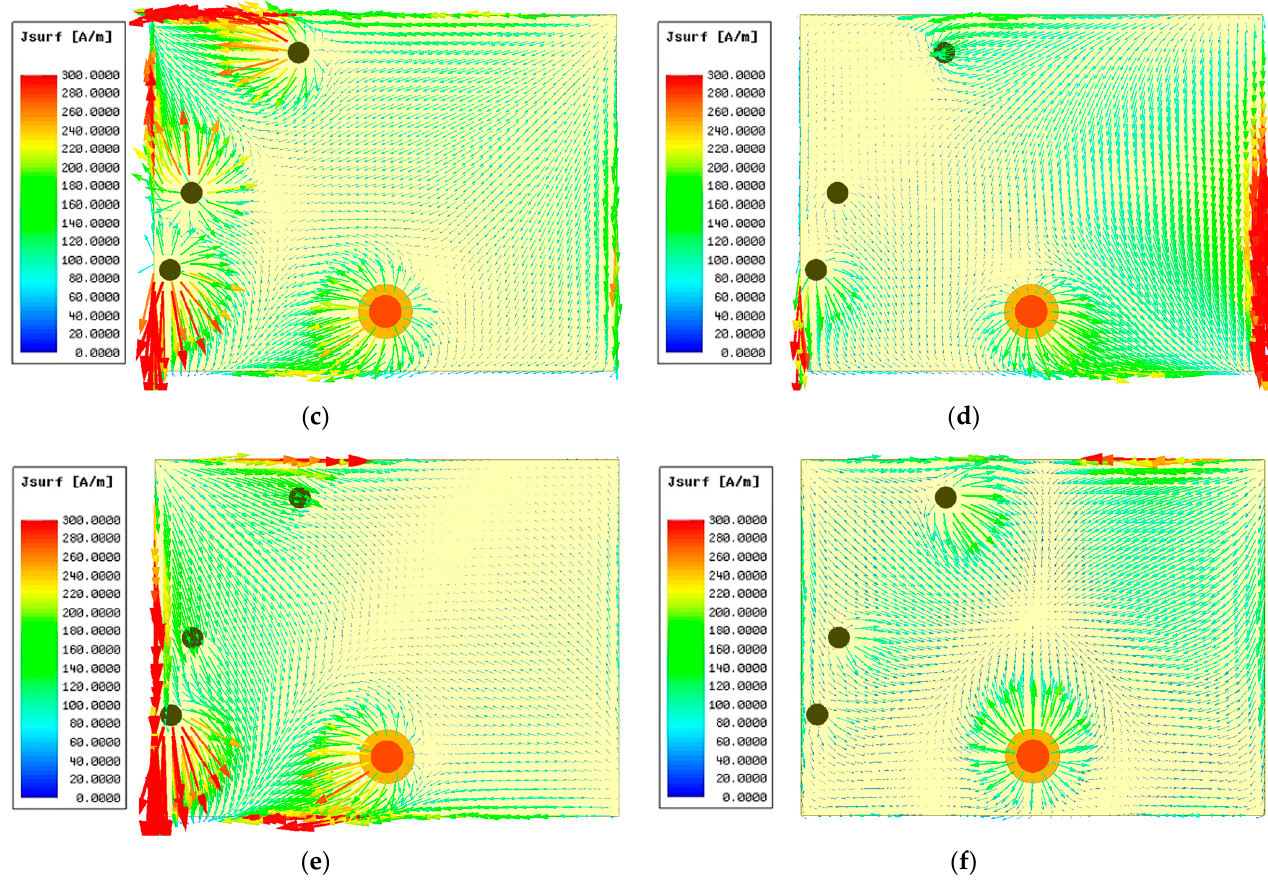
Figure 4. The surface current distributions of ( a , b ) antenna without shorting pin at TM 01 and TM 20 mode and ( c – f ) antenna with shorting pins at 2nd zero mode, TM 01 mode, 3rd zero mode and TM 20 mode.